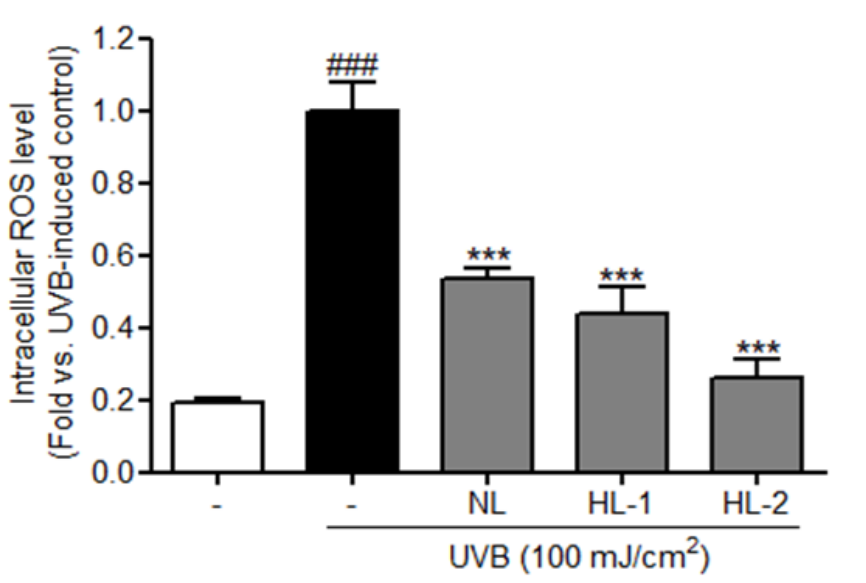
Figure 2. Intracellular ROS levels in UVB-exposed HDFs treated with 100 µ g/mL licorice extracts for 24 h, followed by DCF-DA (20 µ M) treatment for 20 min. Intracellular ROS levels were measured using fluorescent confocal microscopy. Results are shown as the mean ± SD ( n = 3). *** p < 0.001 vs. UVB-exposed control; ### p < 0.001 vs. non-treated control. DCF-DA, 2′,7′-dichlorofluorescin diacetate; HDFs, human dermal fibroblasts; HL-1, heat-treated licorice (120 ◦ C); HL-2, heat-treated licorice (130 ◦ C); NL, non-treated licorice; UVB, ultraviolet B.